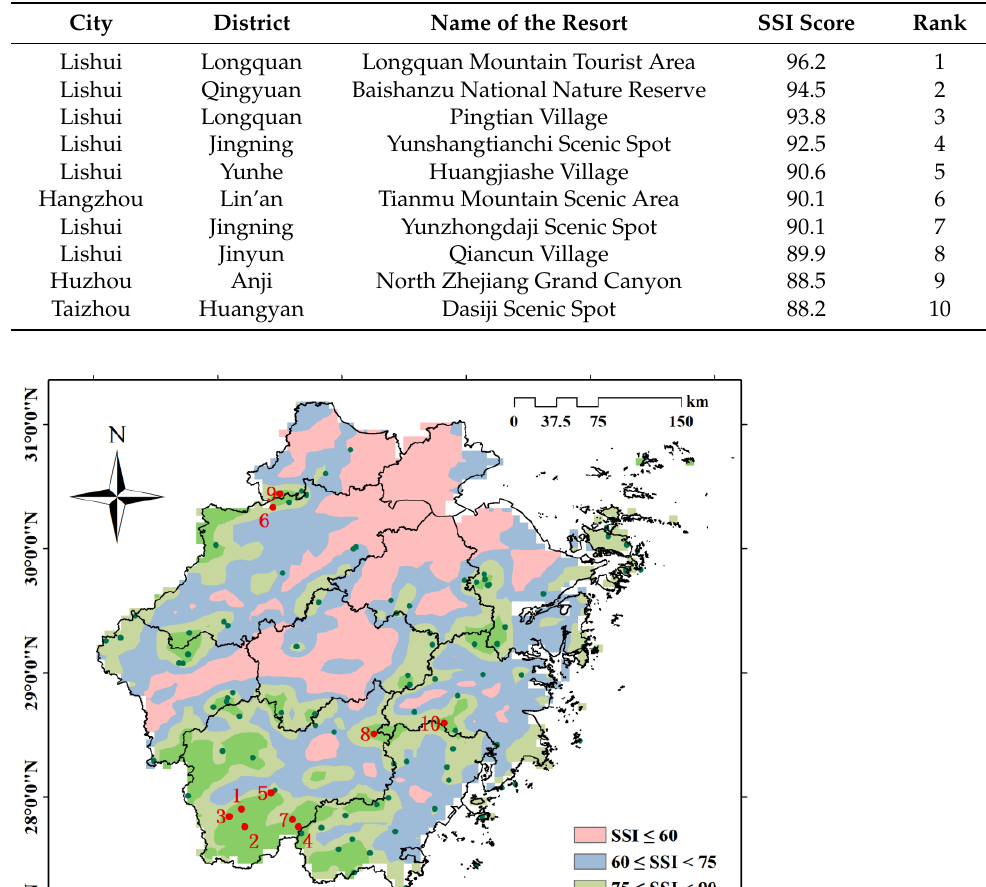
Table 3. Top 10 summer climate resorts in Zhejiang Province.